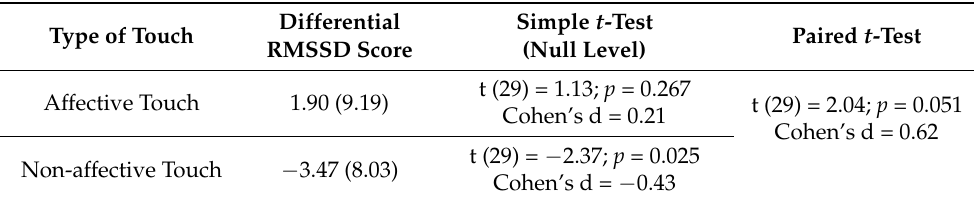
Table 2. Descriptive statistics for each type of tactile stimulation (mean and standard deviation of the differential RMSSD score); simple t -test comparing the differential RMSSD score with the null level; and paired t -test comparing the differential RMSSD score in response to the two different tactile stimulations (affective touch vs. non-affective touch). Differential Simple t -Test Paired t -Test Type of Touch RMSSD Score (Null Level) 1.90 (9.19) Cohen’s d = 0.21 Cohen’s d = 0.62